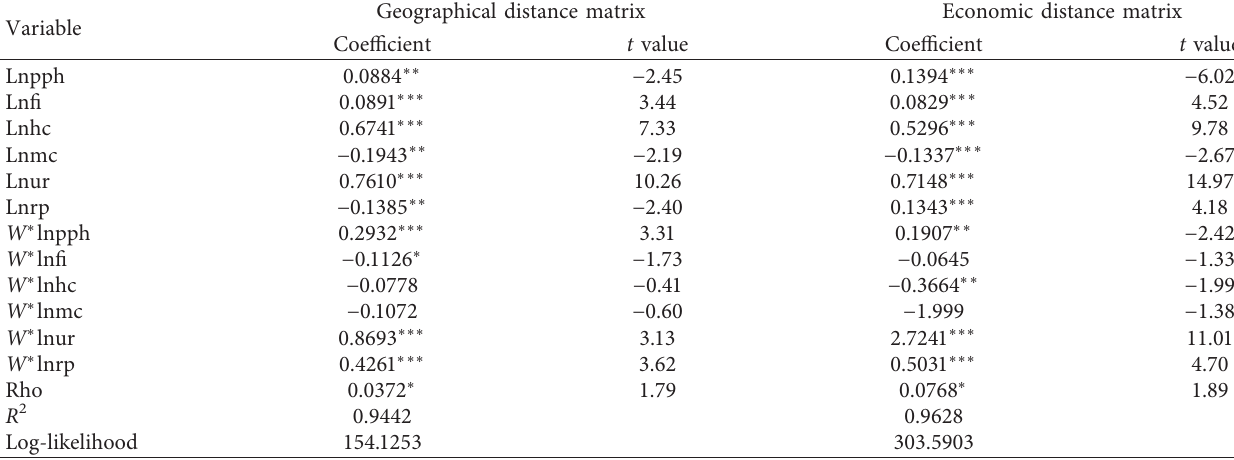
Table 8: Robustness test of public health spending on regional economic growth.